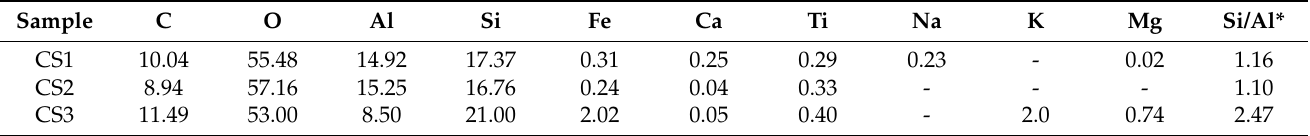
Table 3. Average CS1, CS2, and CS3 element analysis in at. %.